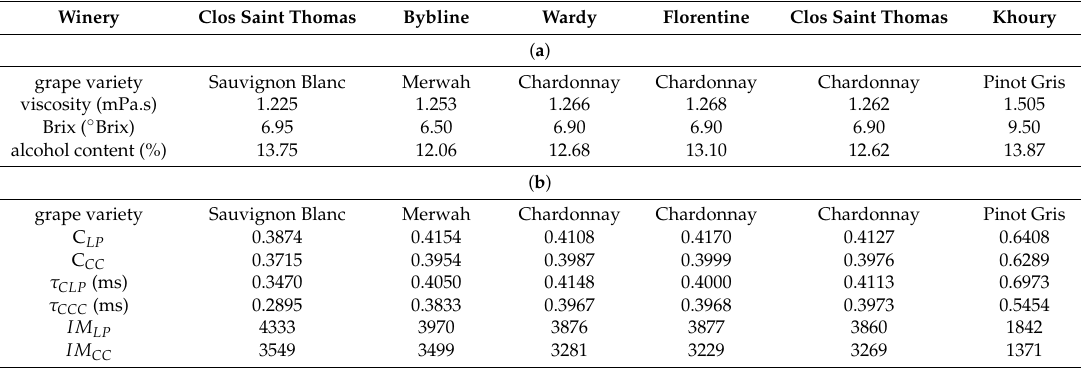
Table 1. Results of the effect of the grape variety on white wine ( a ) viscosity, Brix degree, and alcohol content and ( b ) speckle results in linear parallel (LP) and circular crossed (CC) light polarization configurations. Standard deviations are approximately ± 0.001 mPa.s for the viscosity, ± 0.01 for the Brix degree, ± 0.02% for the alcohol content, ± 0.002 for the contrast C, ± 0.006 ms for the decorrelation time τ C , and ± 170 for the inertia moment IM